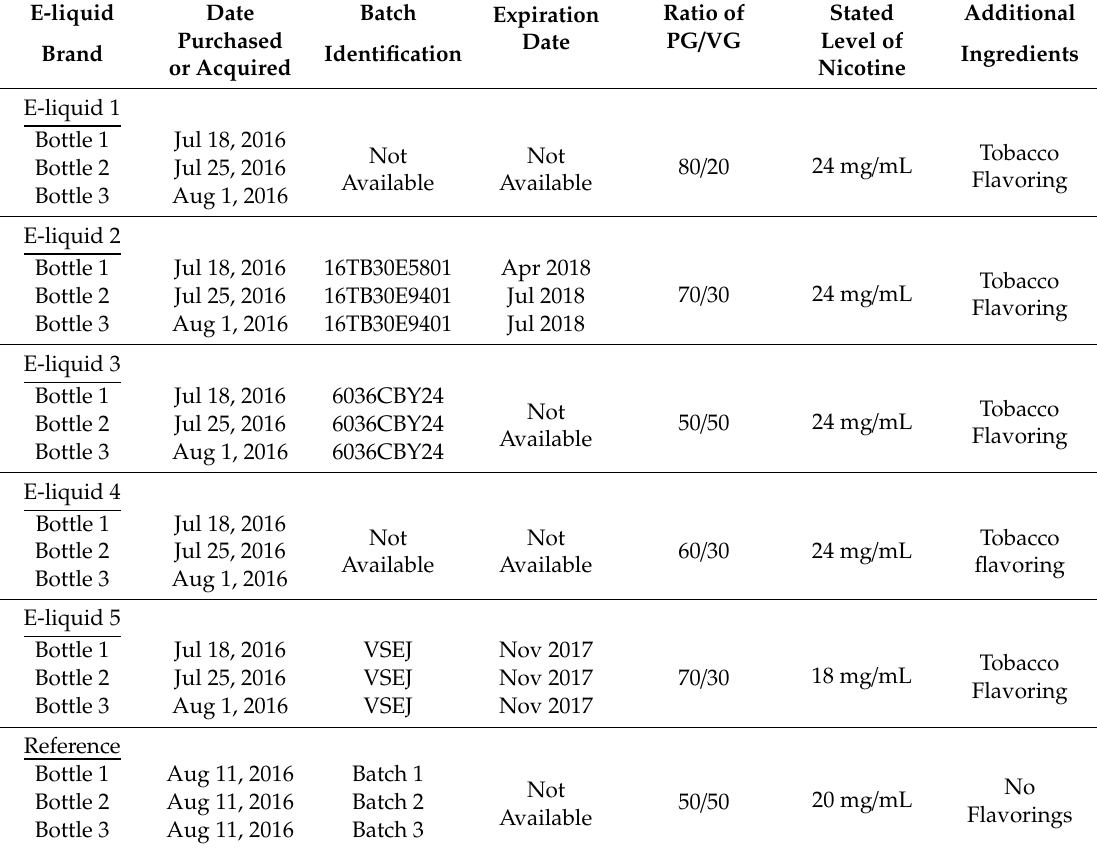
Table 1. Description of E-liquids used in